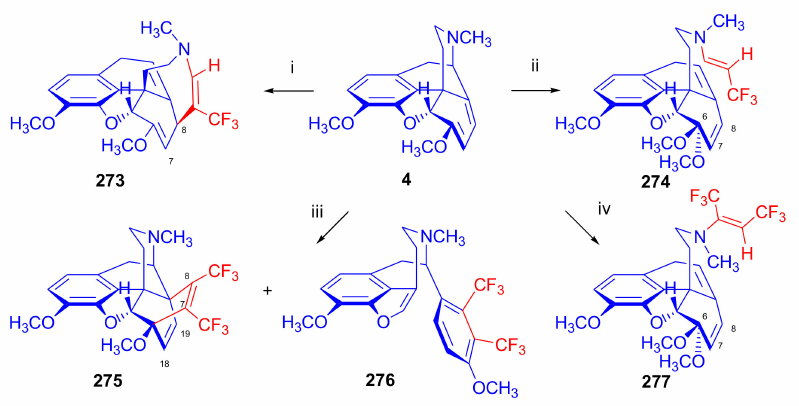
Figure 75. Reaction of thebaine with trifluoromethyl substituted acetylenic dienophiles. Reagents and conditions : (i): trifluoropropyne, sealed tube, room temperature, 18 h; (ii): trifluoropropyne, methanol, 18 h, room temperature; (iii): hexafluoro-2-butyne, benzene, 50 ◦ C, 18 h; and (iv): hexafluoro-2-butyne, methanol, 50 ◦ C, 18